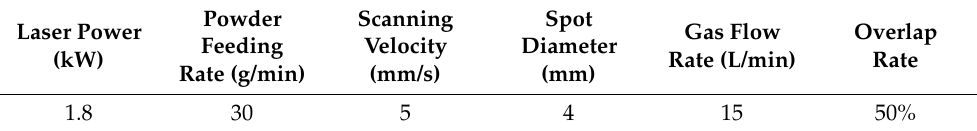
Figure 2. Macroscopic appearance of Ni-based laser-clad coating: ( a ) L1, ( b ) L3. Table 2. Different parameters of laser cladding.